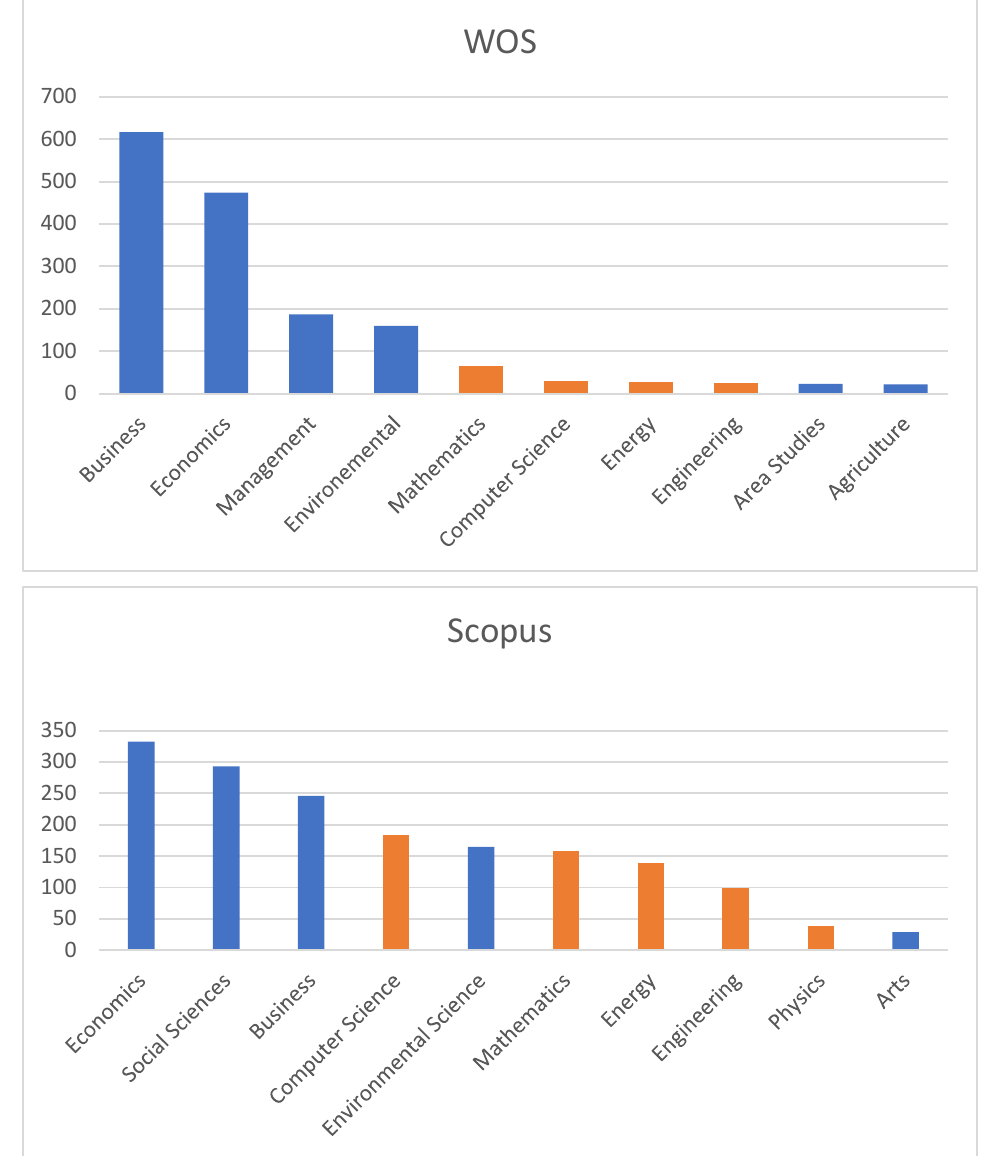
Figure 2. Distribution of journals in both databases by subject areas.